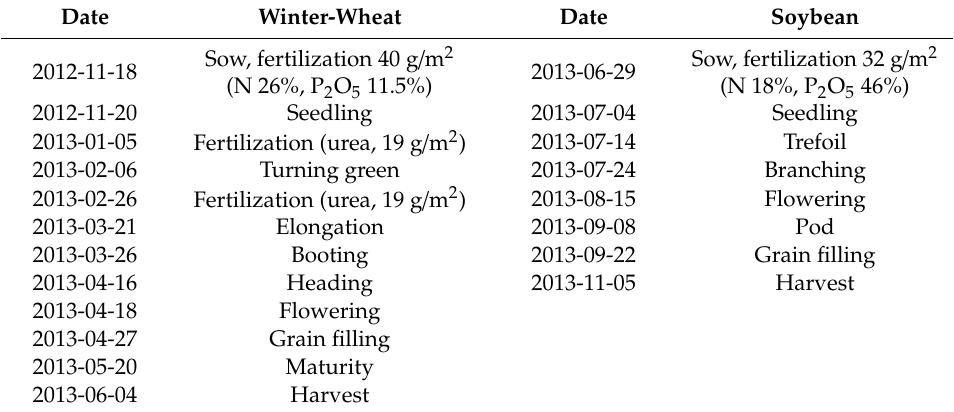
Table 1. Main growth stages and fertilization